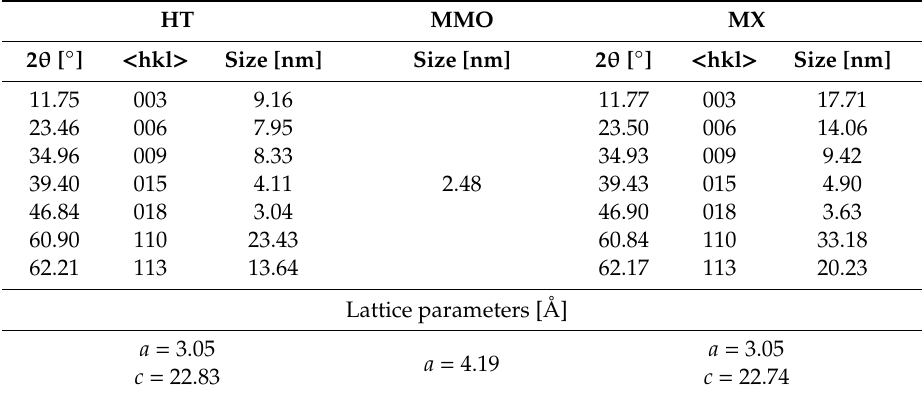
Table 1. Results of the ICP-AES analysis of the prepared catalysts.